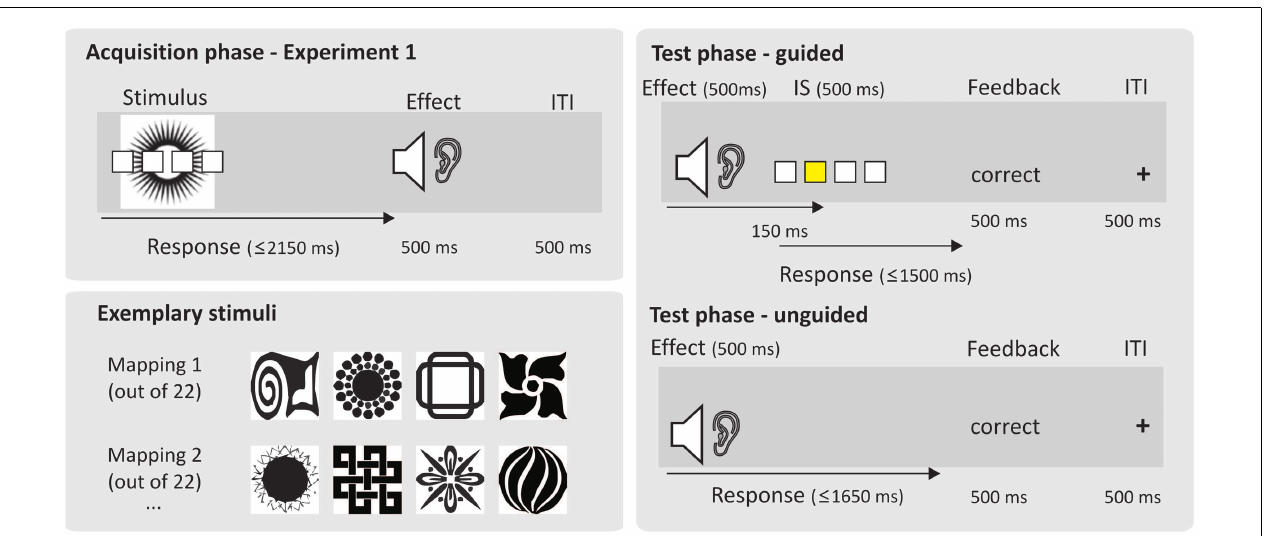
to the CO or DO condition. Responses were to be made with the left middle finger, the left index finger, the right index finger, and the right middle finger mapped to the